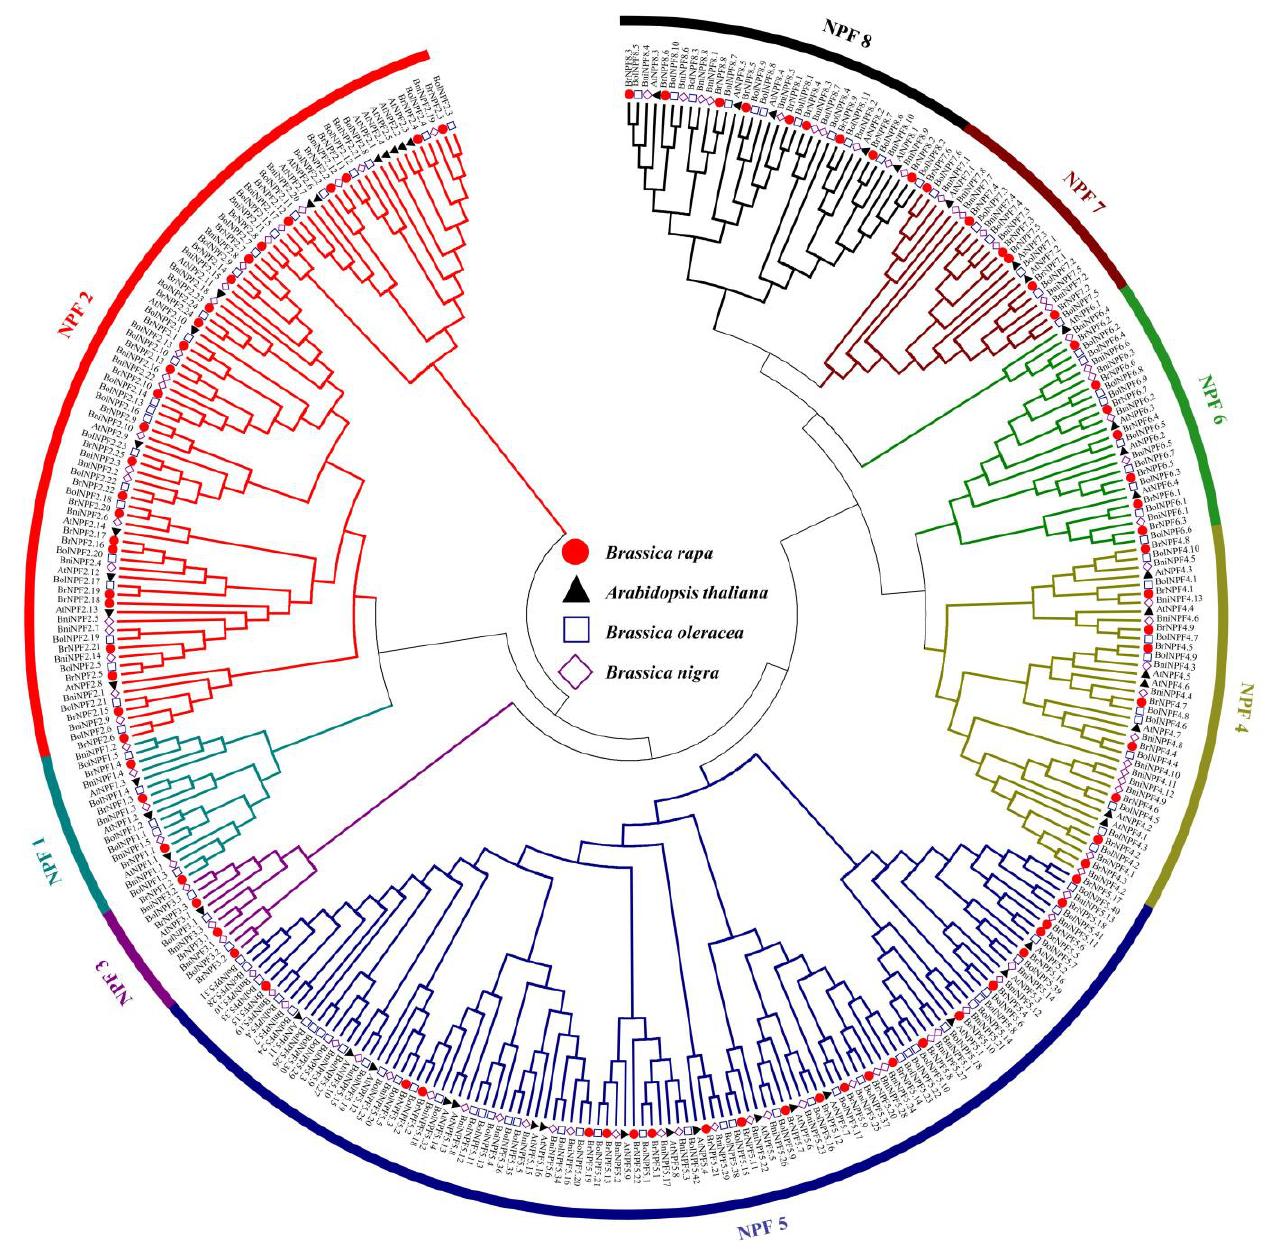
Figure 1. Phylogenetic reconstruction of 345 NPF proteins identified in the genomes of Brassica rapa (n = 85), B. oleracea (110), B. nigra (97), and Arabidopsis (53). The neighbor-joining phylogenetic tree was generated in MEGA6 with full-length NPF protein sequences, and branch support was evaluated with 1000 bootstrap replicates.